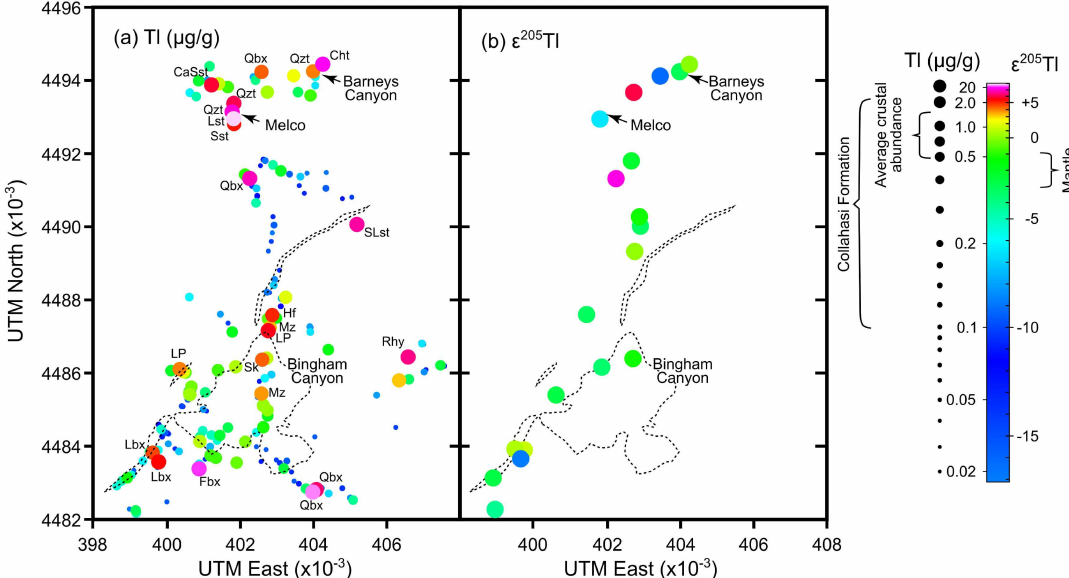
Figure 8. Map of sample locations in the Bingham district, showing ( a ) Tl concentration ( µ g/g) and ( b ) ε 205 Tl value in all analysed samples, using color (a,b) and symbol size (a only); ranges in concentration for the bulk continental crust (values from [61]) and in rocks from the Collahuasi Formation (values from [48]) are also marked on the key for reference, as is the range of ε 205 Tl for the mantle [31,41]; dashed lines delineate the extents of the main intrusive bodies of the Bingham complex; locations of Melco and Barneys Canyon mines also shown; samples with high Tl concentrations are shown with abbreviated lithologies as follows: CaSst = calcareous sandstone; Cht = chert; Fbx = fault breccia; Hf = hornfels; Lbx = limestone breccia; LP = latite porphyry; Lst = limestone; Mz = monzonite; Qbx = quartzite breccia; Qzt = quartzite; Rhy = rhyolite; Sk = skarn; SLst = silicified limestone; Sst =